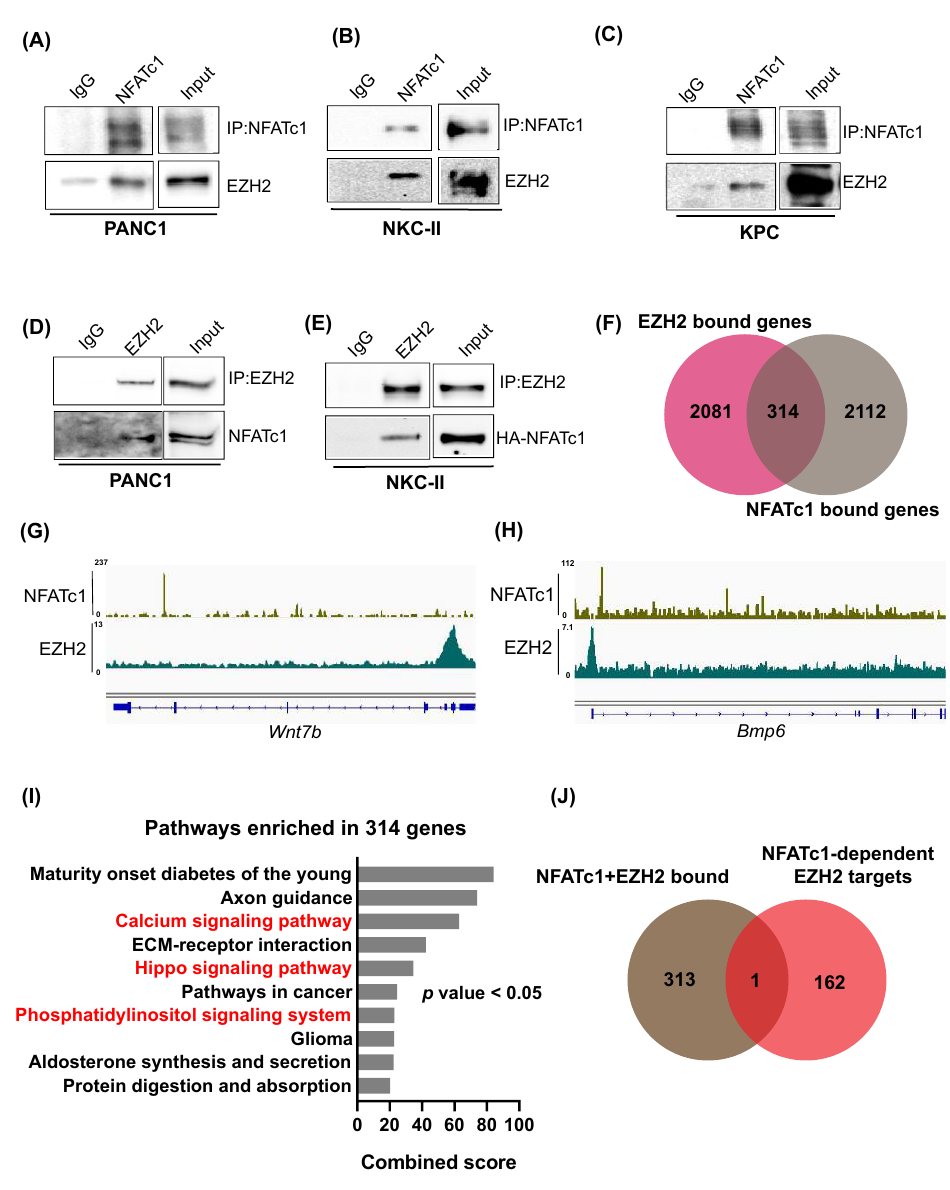
Figure 4. NFATc1 and EZH2 biochemically interact with each other, but are not involved in joint regulation of direct target gene transcription. ( A – E ) Immunoprecipitation of endogenous NFATc1 ( A – C ) and endogenous EZH2 ( D , E ) in the indicated cells lines was followed by Western Blot analysis. IP studies in A–C were performed in whole cell lysates, while nuclear lysates were utilized for IPs depicted in D,E. ( F ) Overlay of target genes bound by NFATc1 and EZH2 as identified by ChIP-seq analysis [7,15] in NKC-II cells. ( G , H ) IGV profiles demonstrating NFATc1 and EZH2 occupancy on the Wnt7b ( G ) and Bmp6 ( H ) genes in NKC-II cells. ( I ) Pathways (as identified by EnrichR) enriched in the 314 NFATc1- and EZH2-bound genes. Cancer-related pathways are highlighted in red. Pathways were sorted based on combined score and the top 10 pathways were plotted. p values < 0.05 were considered significant. ( J ) Overlay of NFATc1- and EZH2 bound genes with the 163 NFATc1 -dependent EZH2 target genes (as shown in Figure